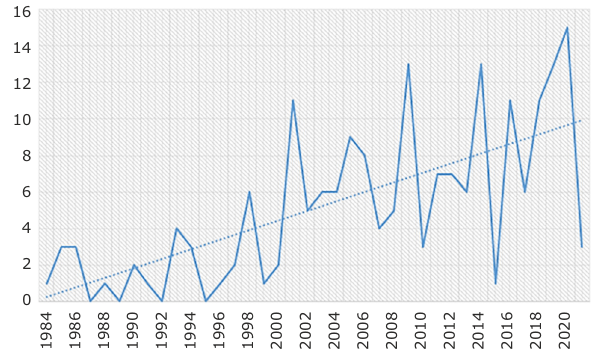
Figure 2. Distribution of publications by year